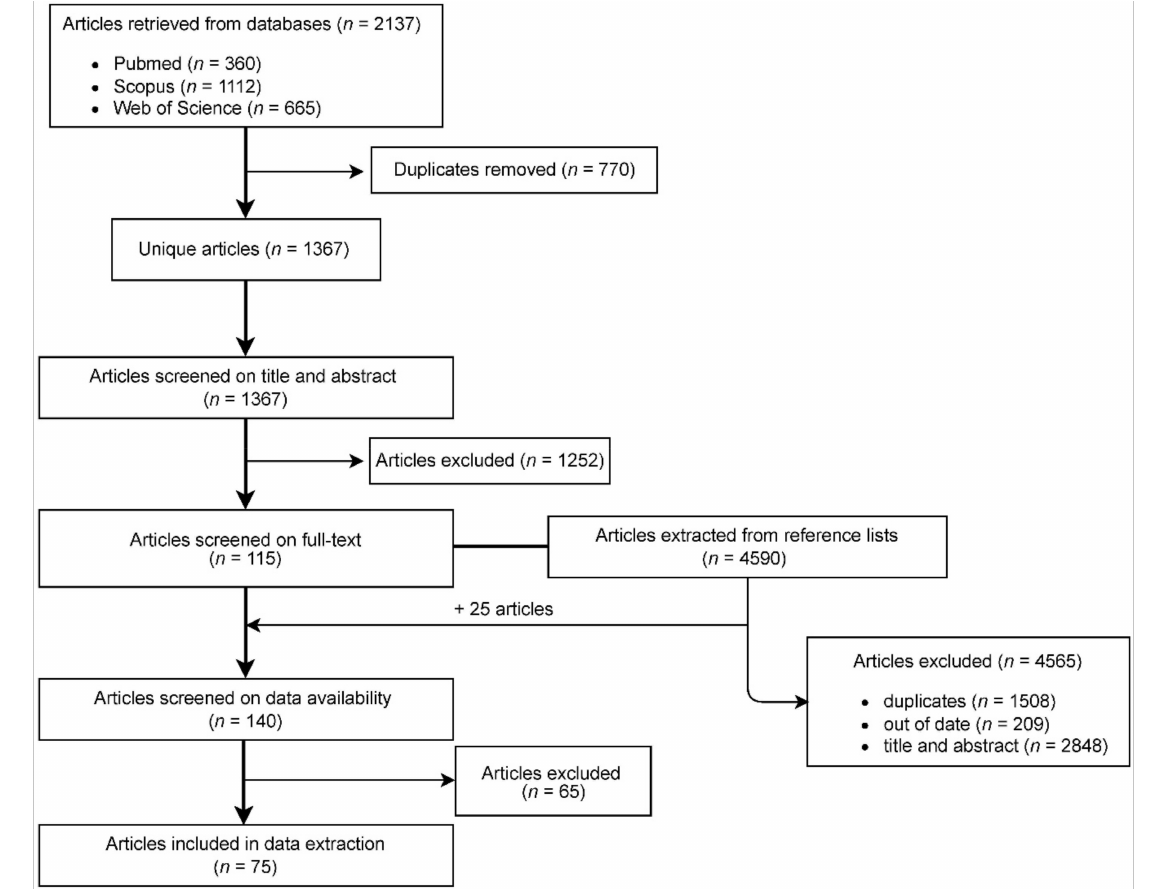
Figure 1. Flow diagram of the selection process for studies ( n = number of